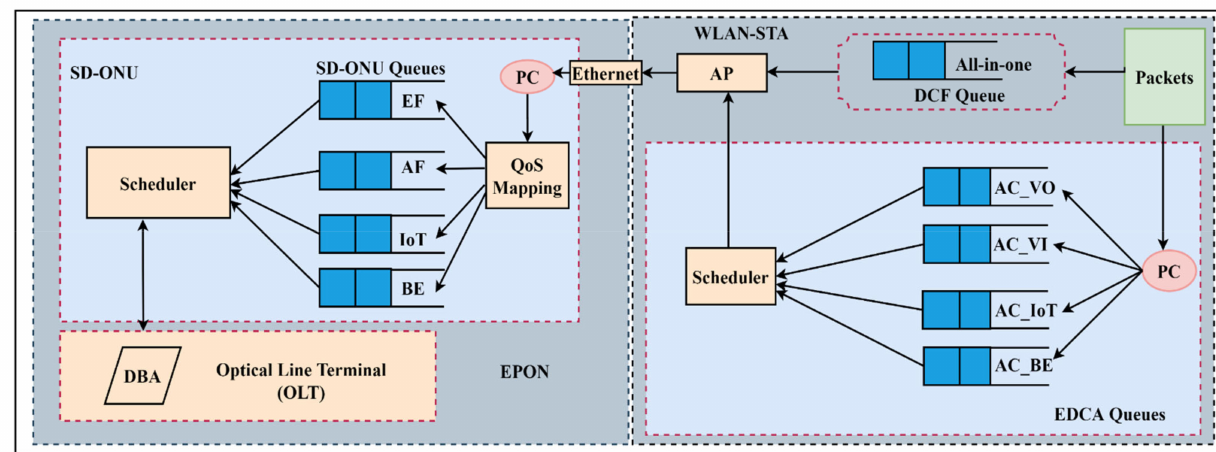
Figure 3. Proposed SD-FiWi QoS mapping architecture.